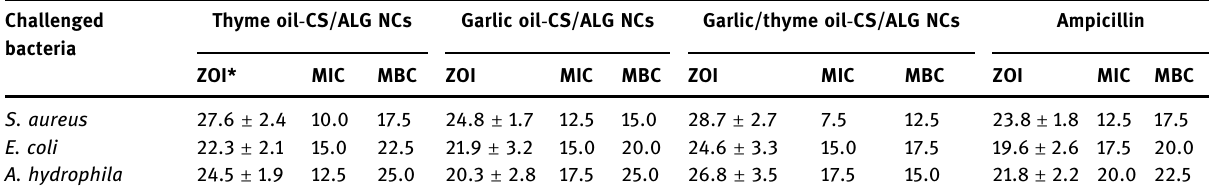
Table 2: Antimicrobial activity of thyme oil - CS/ALG NC, garlic oil - CS/ALG NC, and garlic/thyme oil - CS/ALG NC against bacterial strains